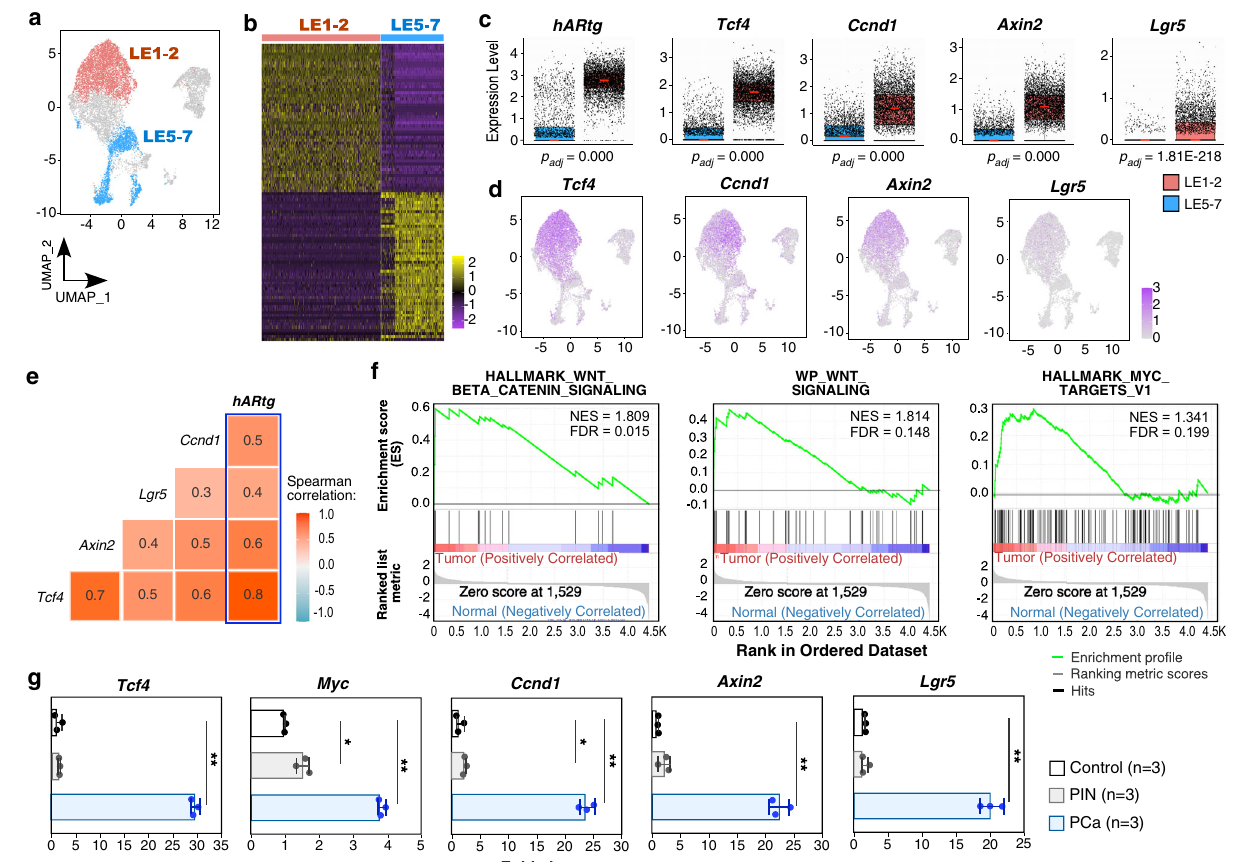
Fig. 4 | Activating Wnt signaling pathways in hARtg positive prostatic tumor cells.a UMAPplothighlightingLE1-2andLE5-7clustersidenti fi edas hARtg +tumor cell clusters and hARtg -normal cell clusters, respectively. b Heatmap showing top 50differentiallyexpressed genesbetweenLE1-2( n =5122)and LE5-7( n =2743)cell clusters. Yellow and purple indicate high and low expression, respectively. c Box plots representing scaled expression data for hARtg and Wnt downstream target genesappliedtoLE1-2andLE5-7cells.Pinklinesmarkthemedian;topandbottom lines of boxes indicate the boundaries of the fi rst and third quartiles, respectively; the top and bottom whiskers show the maximum and minimum values, respec- tively, excluding outliers. P -values were computed using Wilcoxon rank-sum test (two-sided)andadjustedusingBenjamini-Hochbergcorrection. d Geneexpression UMAP plots displaying the expression patterns for the indicated Wnt downstream